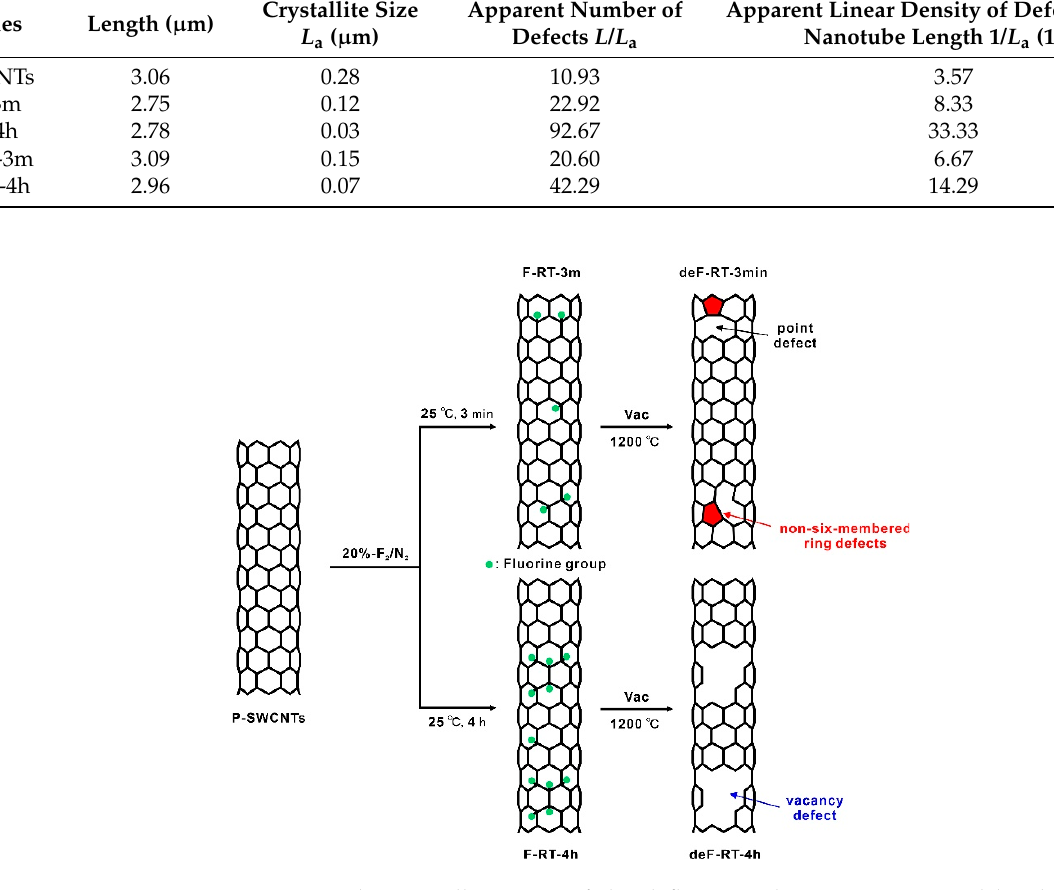
Figure 6. Schematic illustration of the defluorinated SWCNTs prepared by the fluorination–defluor- ination